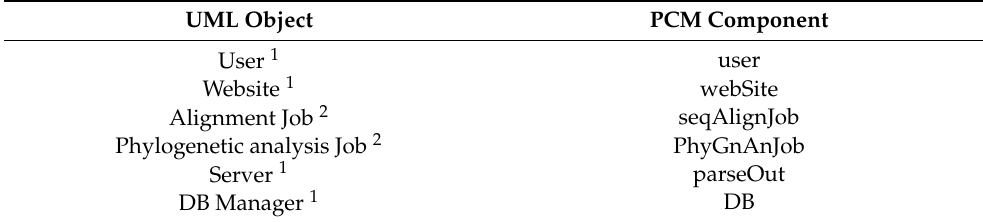
Table 1. UML objects and their corresponding components.